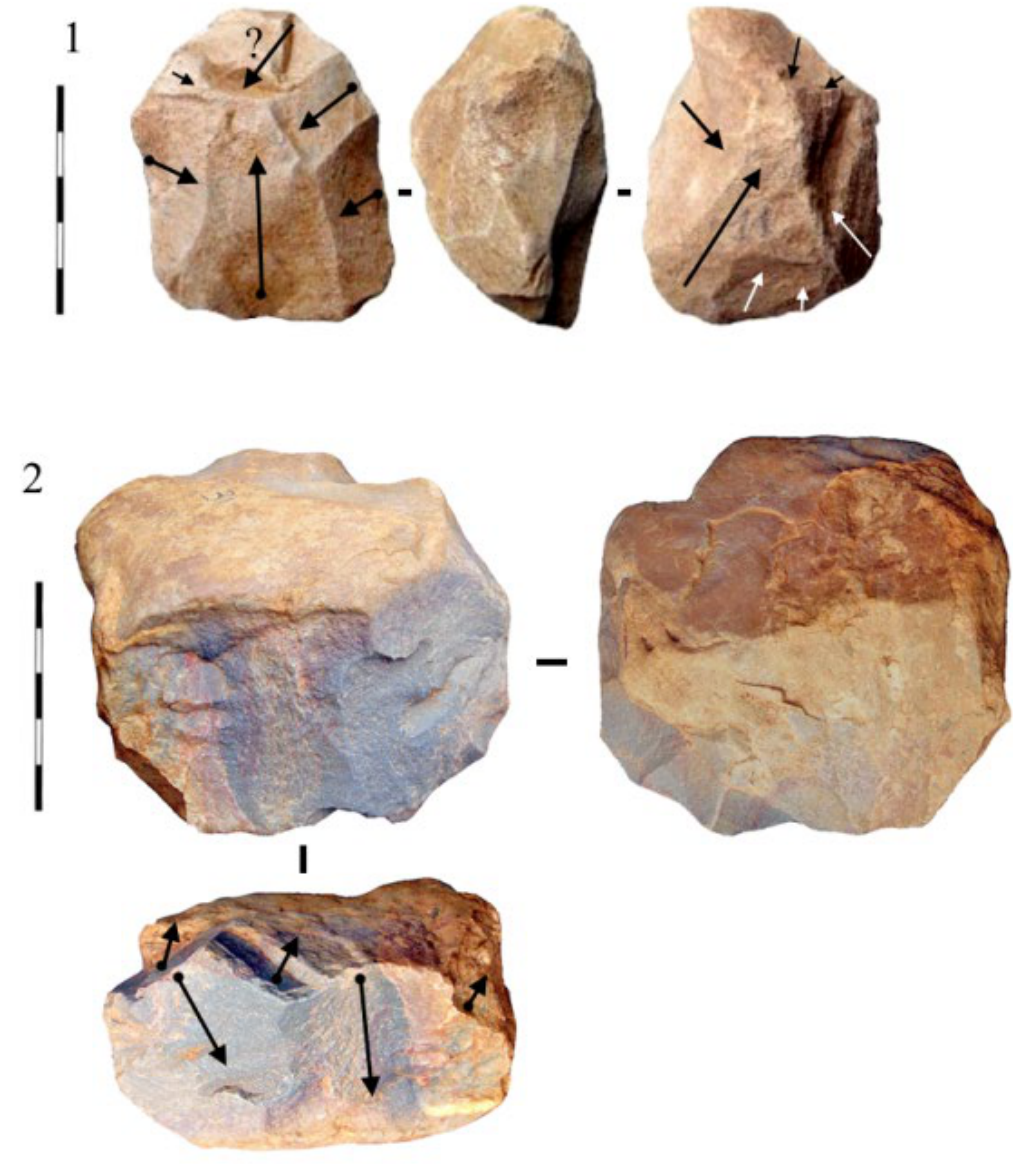
Figure 7. Cores of Camillo. 1: Lineal Levallois core on Jurassic flint. 2: Partial discoid core on quartzite. Scale bar: 5